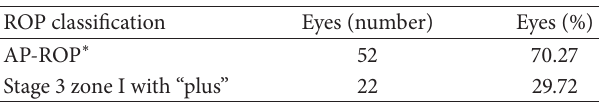
Table 2: Classification of ROP in the eyes treated with intravitreal injections of